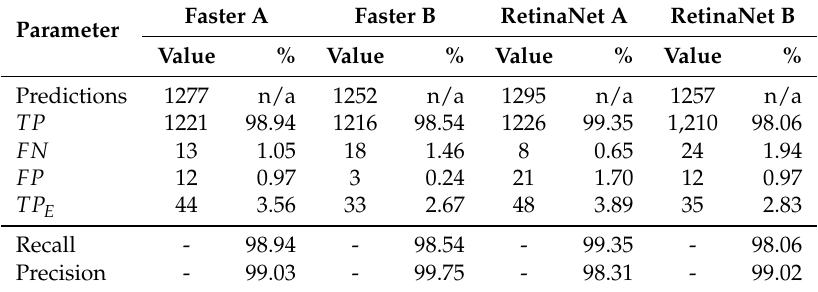
Table 5. Summarized localization performance results (IoU > 0.5, score > 0.85). Percentages are expressed on the actual number of grains to be located (excluding grains partially visible at the